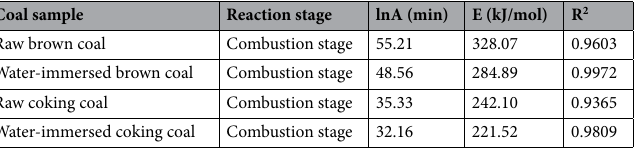
Coal sample Reaction stage lnA (min) E (kJ/mol) R 2 Raw brown